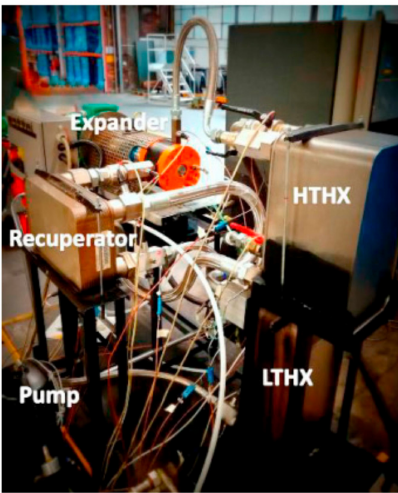
Figure 11. A general view of the ORC test stand implemented at Politecnico di Milano [80]. Reproduced withpermissionfromStefanoMurgiaandGianlucaValenti, EnergyProcedia;